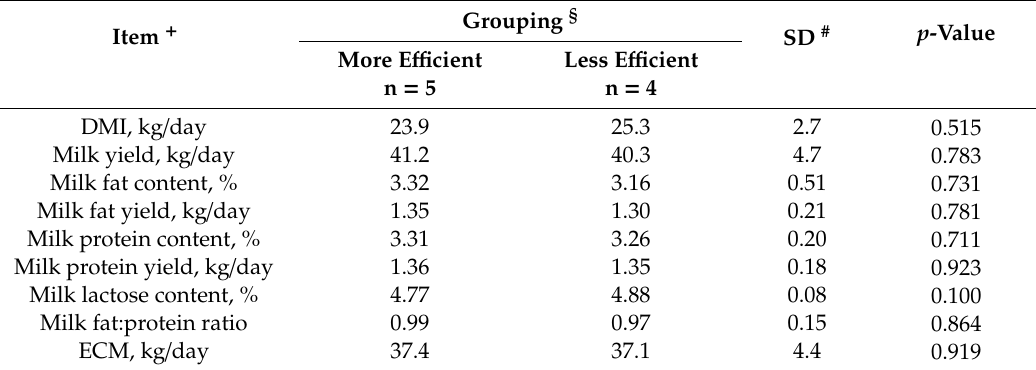
Pooled standard deviation.